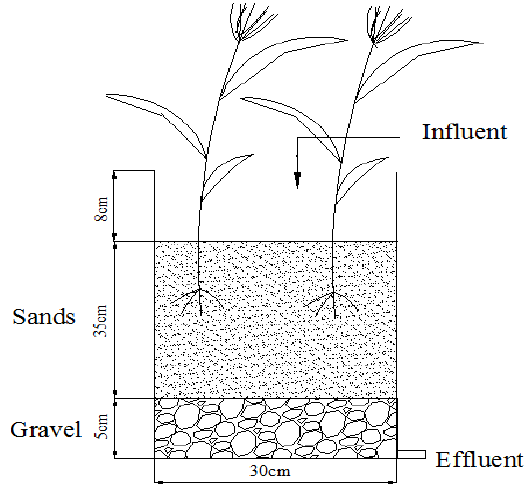
Figure 1. The size parameters of the wetland microcosms.